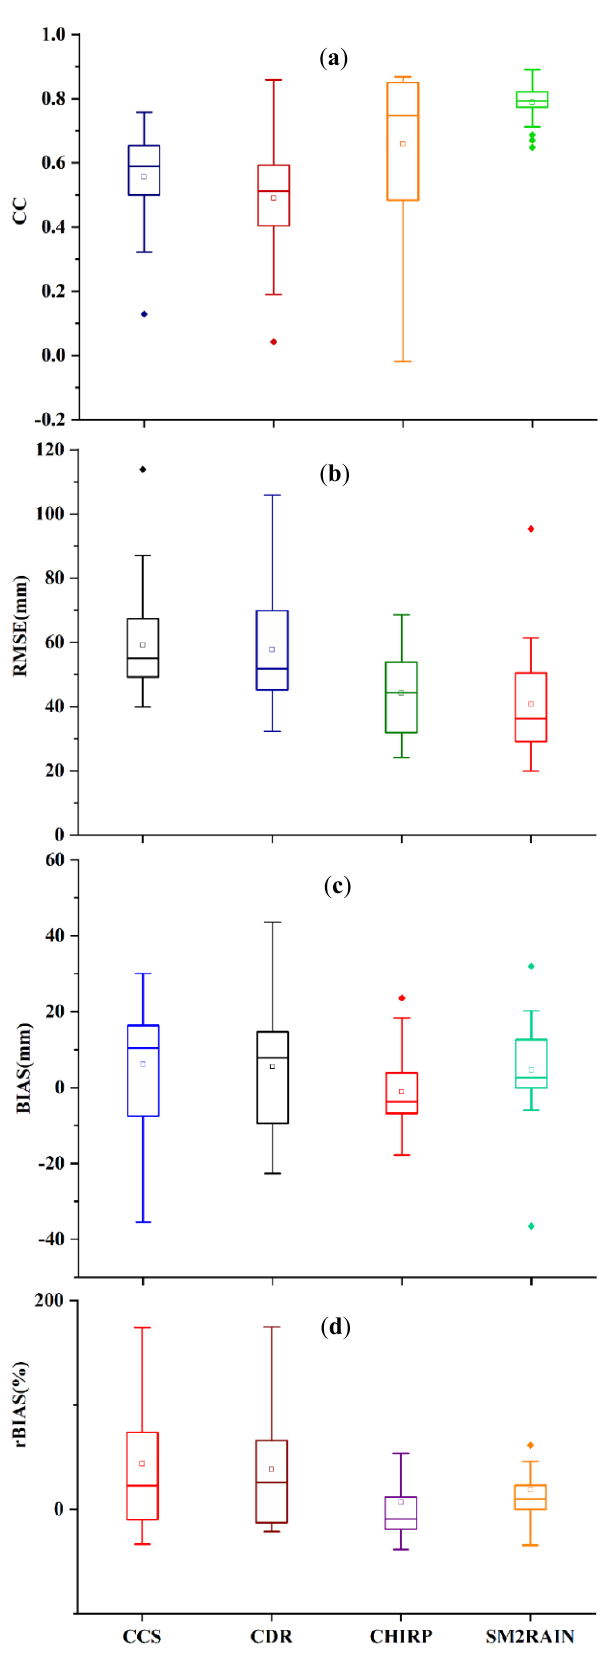
Figure 5. Box plots of monthly values of the ( a ) CC, ( b ) RMSE), ( c ) BIAS, and ( d ) rBIAS forSM2Rain- ASCAT, CHIRPS-2.0, PERSIANN-CDR, and PERSIANN-CCS.